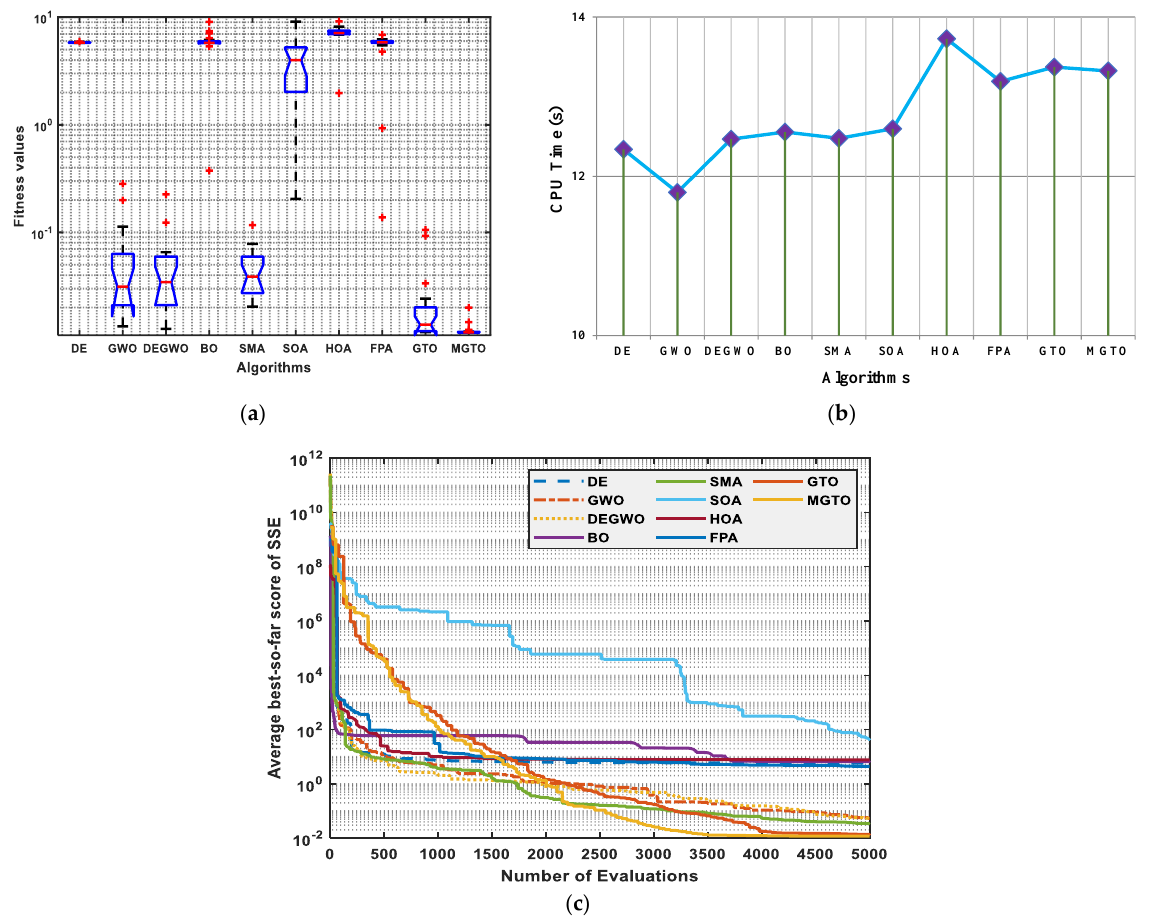
Figure 4. Comparison among algorithms in terms of five-number summary (boxplot), convergence speed, and CPU time on test case 1: ( a ) boxplot of the obtained outcomes, ( b ) CPU time, ( c ) convergence curve.